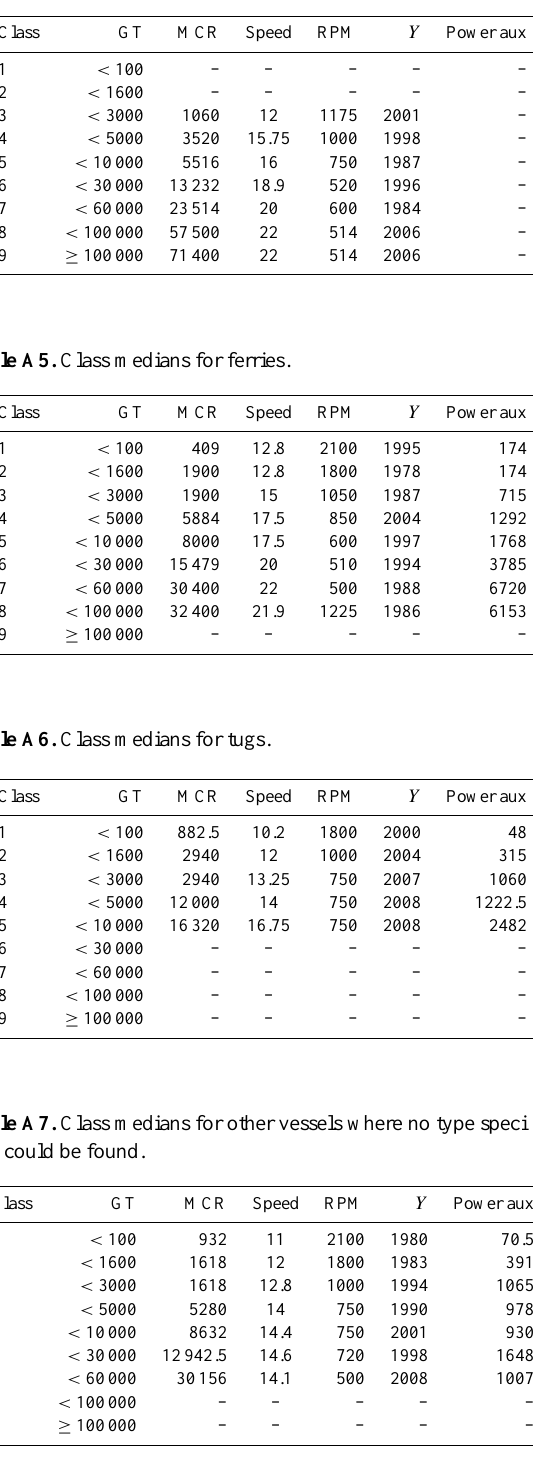
Table A4. Class medians for cruise ships. As the majority of the cruise ships use their main engines instead of auxiliary engines to generate electricity, 40% of the MCR was used as the total power of auxiliary engines. The value of 40% was derived from evaluating cruise ships with no diesel electric engines.